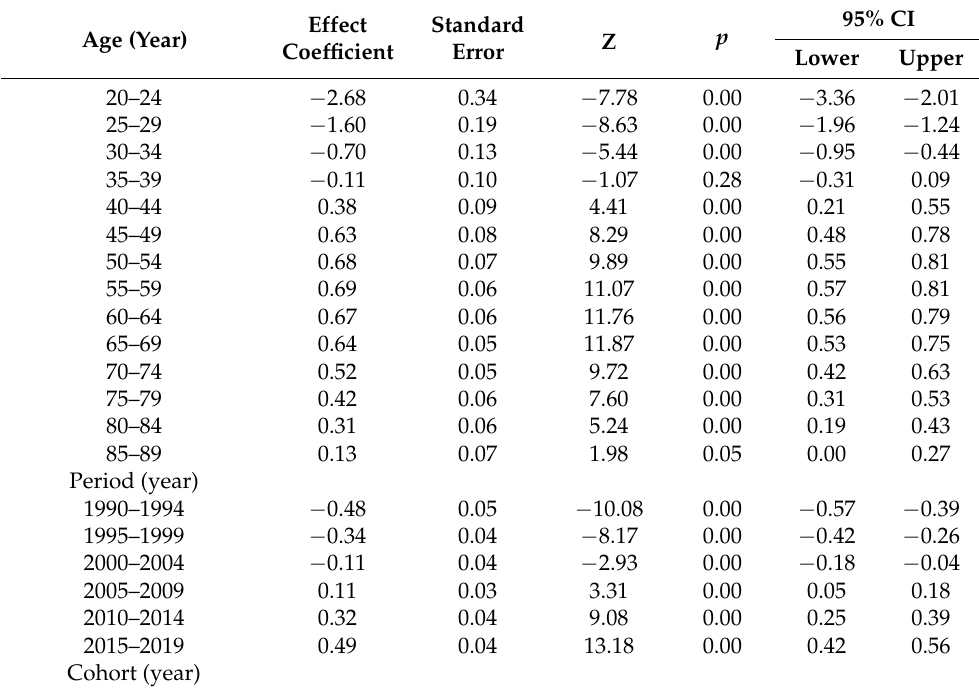
Table 2. Age-period-cohort model of the incidence of breast cancer in Chinese women from 1990 to